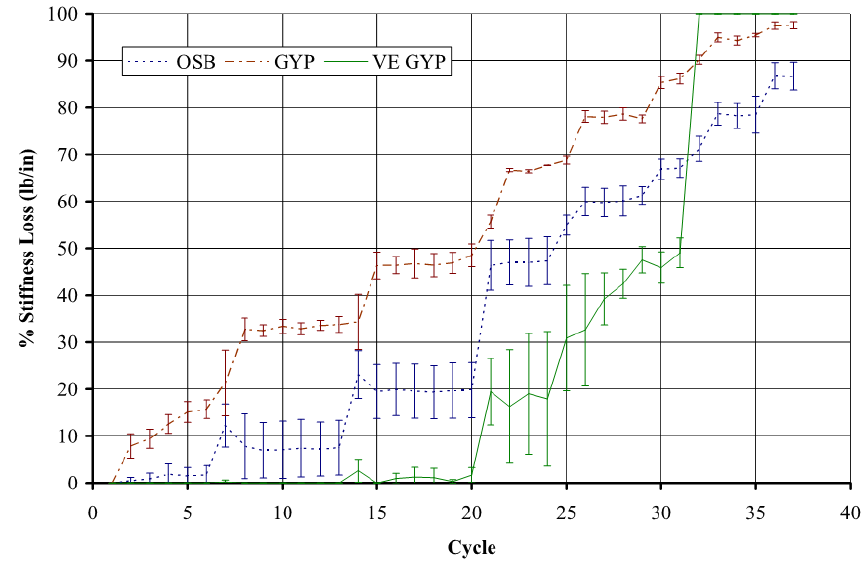
Figure 12. Average stiffness vs. cycle number for